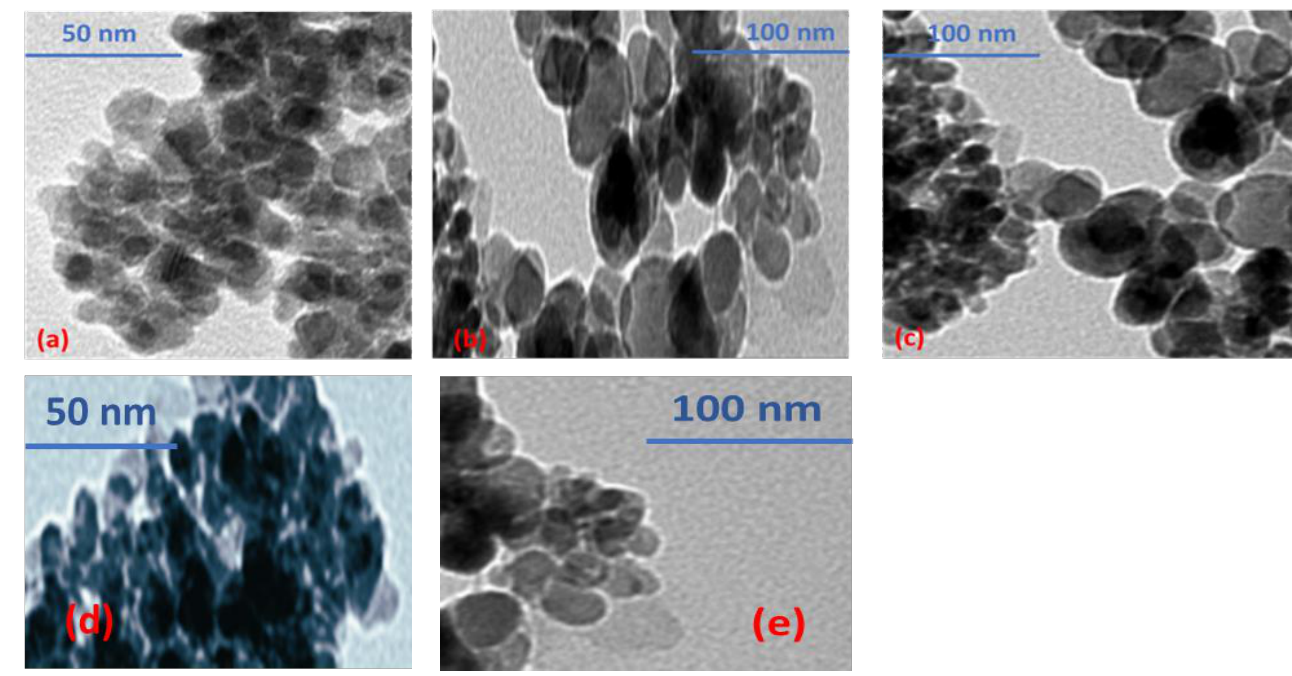
Figure 3. (a, b, c): TEM image of FeS_2 at 400 ℃ . (d, e): TEM image of FeS_2 at 350 ℃ . Figure 3. ( a – c ): TEM image of FeS